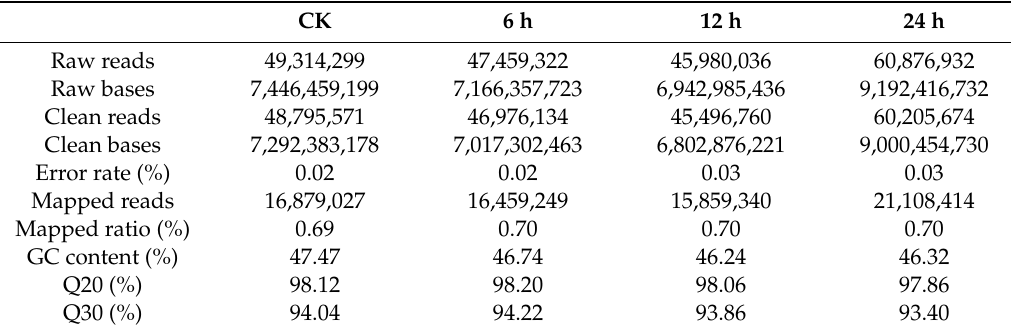
Table 1. Summary of sequencing data quality control.